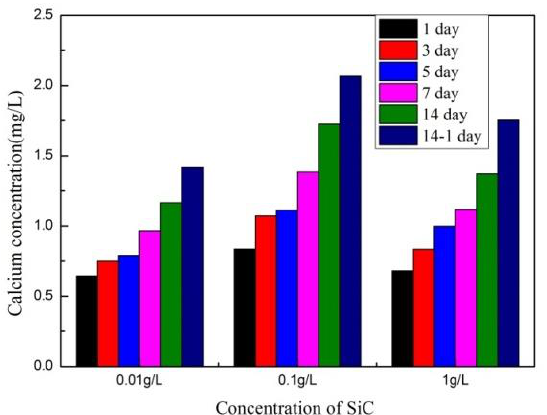
Figure 11. Calcium concentration of different SiC particle (200 nm) concentrations.